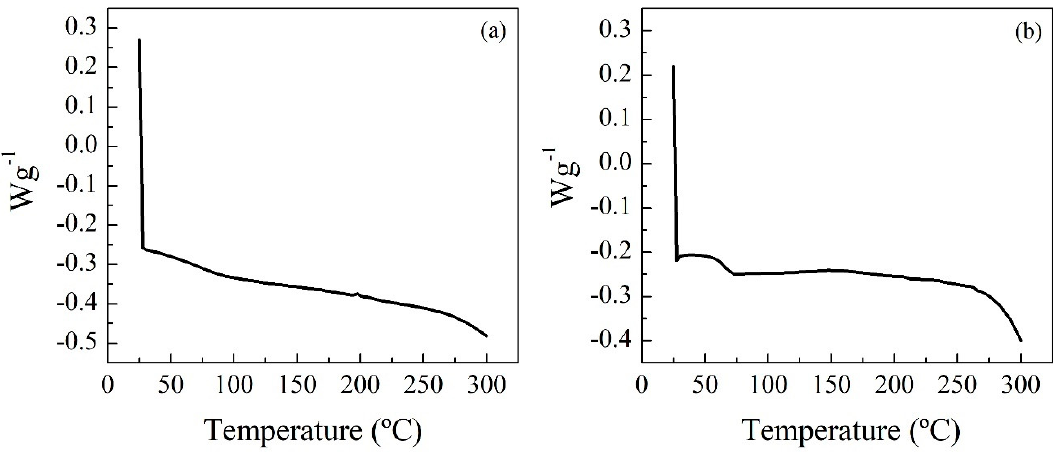
Figure 3. DSC curves of RPUF ‐ B ( a ) and RPUF ‐ C ( b ).